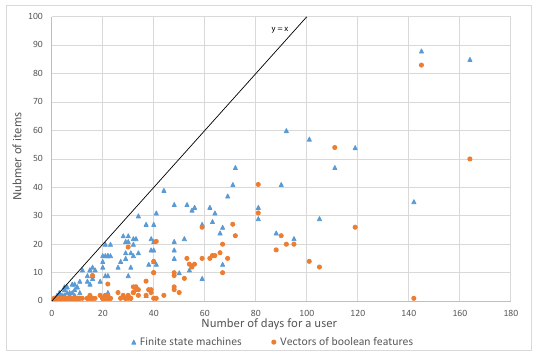
Figure 4: Number of finite state machine created and number of unique boolean features combina- tions as a function of the number of days per user.